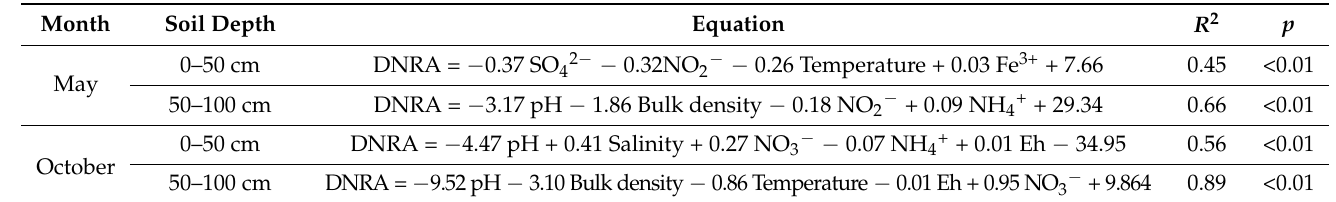
Table 1. Multiple linear regression equations for DNRA versus environmental factors measured at 0–50 cm and 50–100 cm depths across the region in two